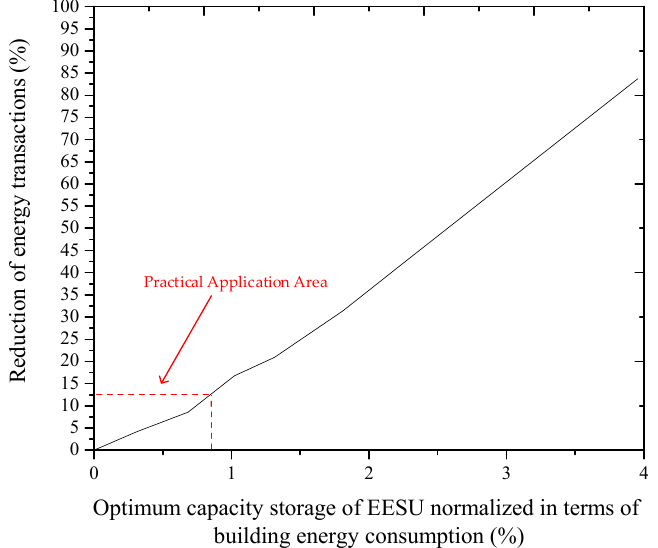
Figure 8. Interrelation between the energy transactions reduction and the optimum storage capacity. Table 4. Optimization of electrical energy storage unit.